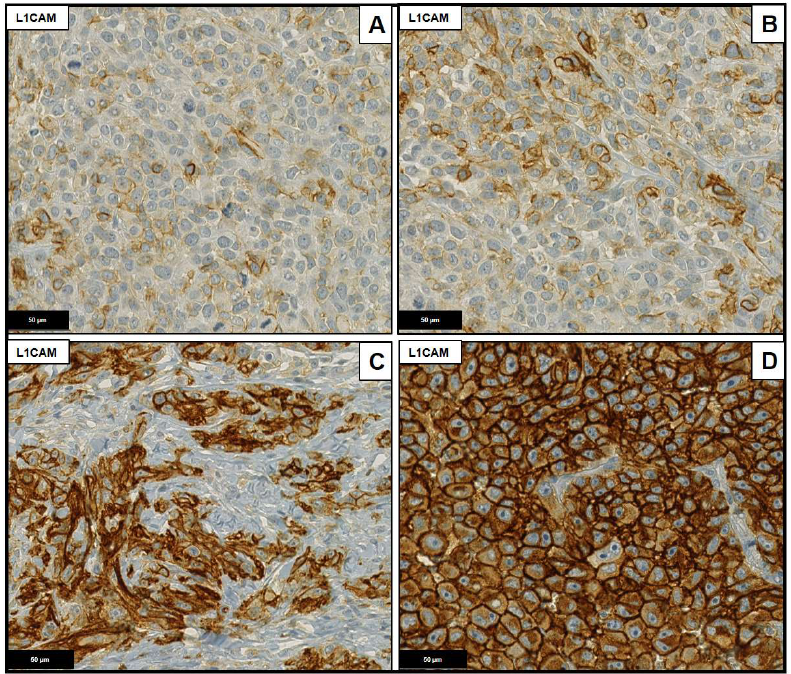
Figure 6. L1CAM staining, magnification 40×. ( A ) Score 1: up to 10% positive cells. ( B ) Score 2: 11% to 50%. ( C ) Score 3: 51% to 90%. ( D ) Score 4: >90%. Table 6. Details of immunohistochemical antibodies. For Ki67 the hot spot was chosen and positive tumor cells per 100 tumor cells were